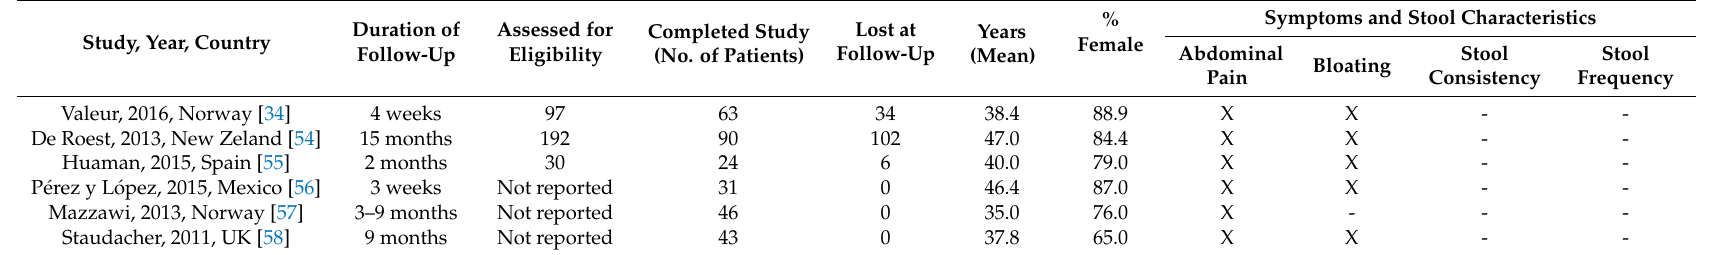
Table 2. Characteristics of the included cohort studies in the